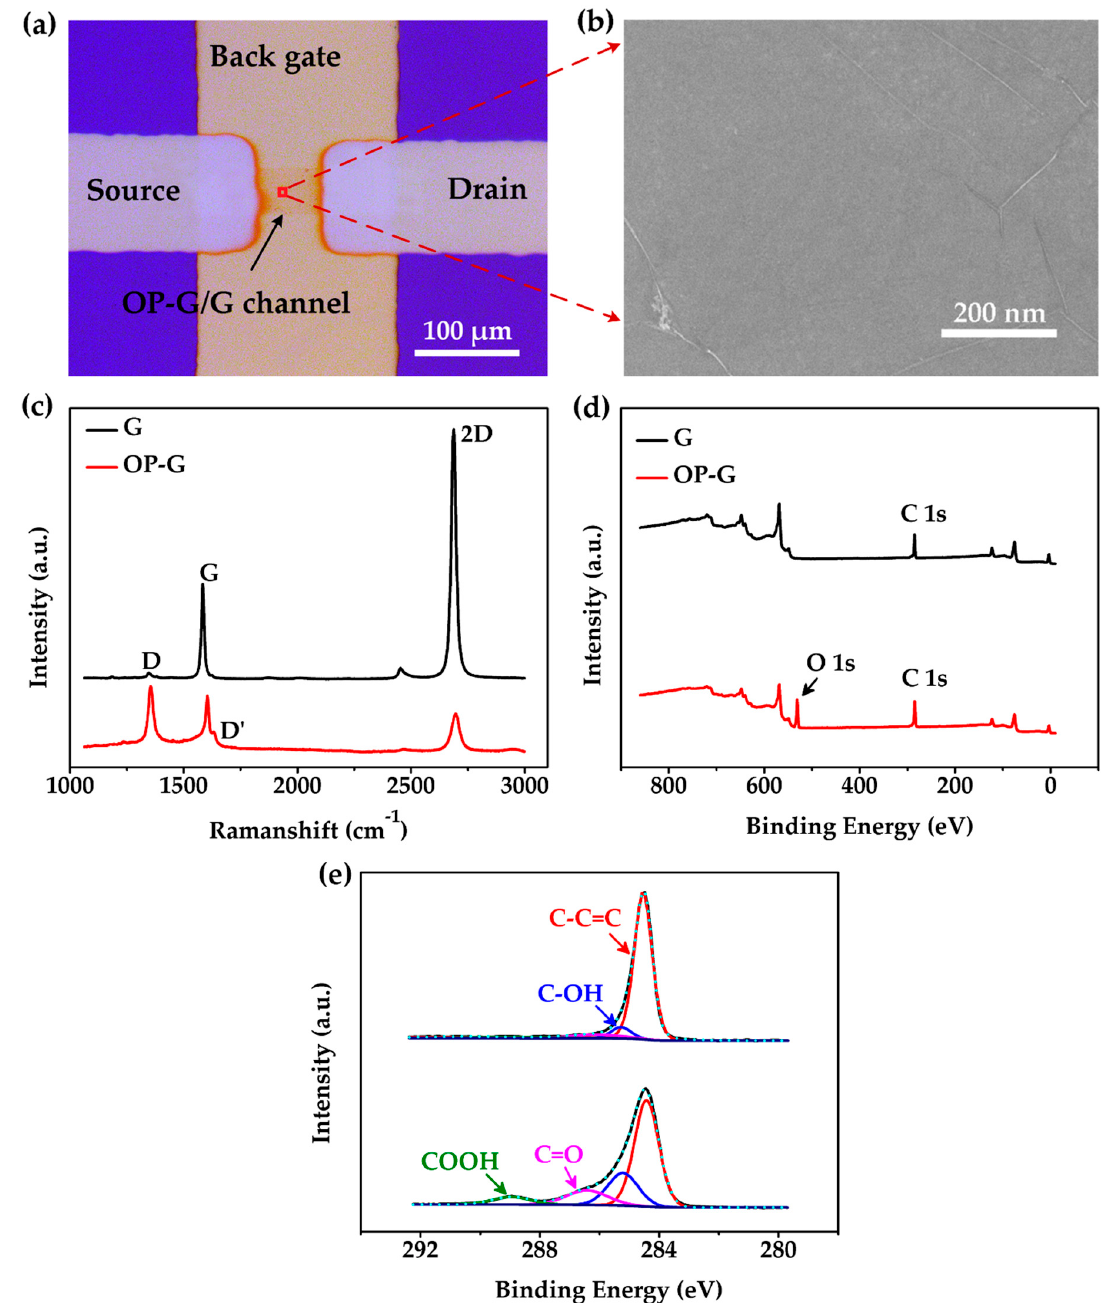
Figure 3. Material characterization. ( a ) Optical microscope image of the composite OP-G/G channel. ( b ) The FESEM image of the channel at the red square highlighted area of (a). ( c ) Raman spectra of pristine graphene (G) and oxygen plasma-treated graphene (OP-G) samples. ( d ) XPS survey spectra and ( e ) zoom-in plot and fittings of C 1s peak in XPS spectra. Table 1. XPS analysis of C 1s peak of G and OP-G.